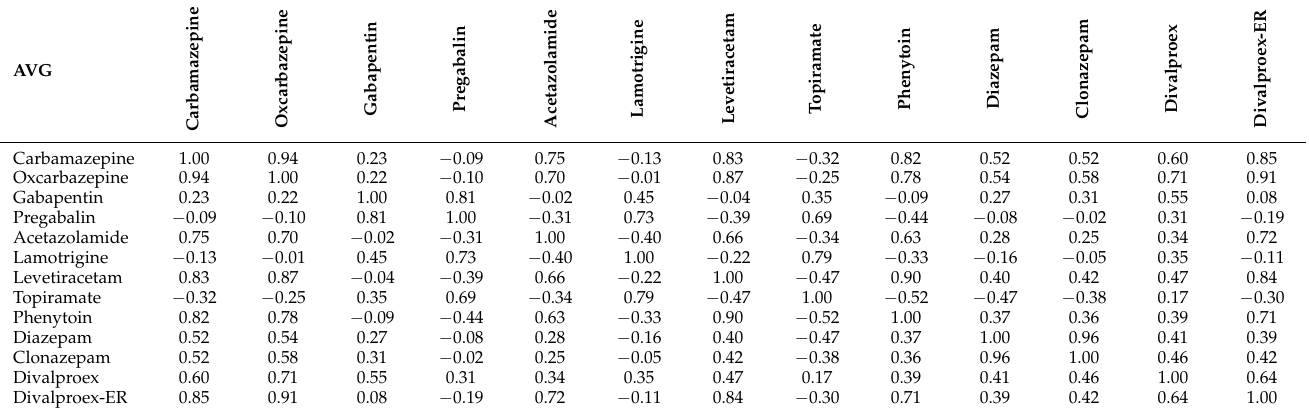
Table 11. Average AEDs Drug-Drug Similarity-based